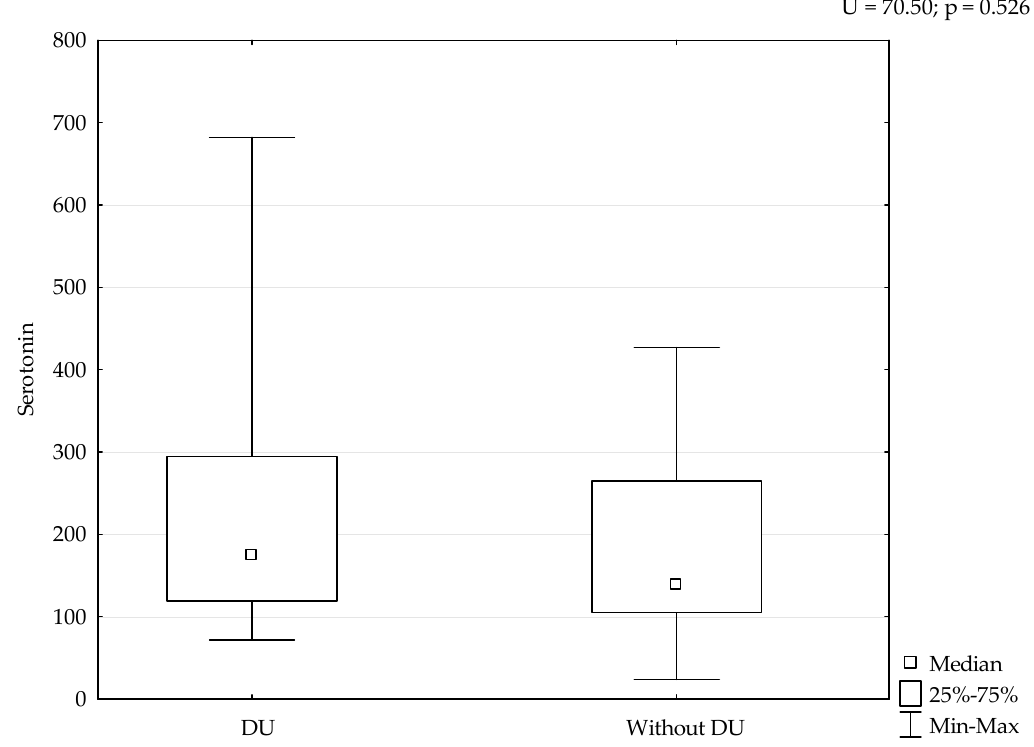
Figure 2. Levels of serotonin considering DU . Serotonin is expressed as ng/mL.